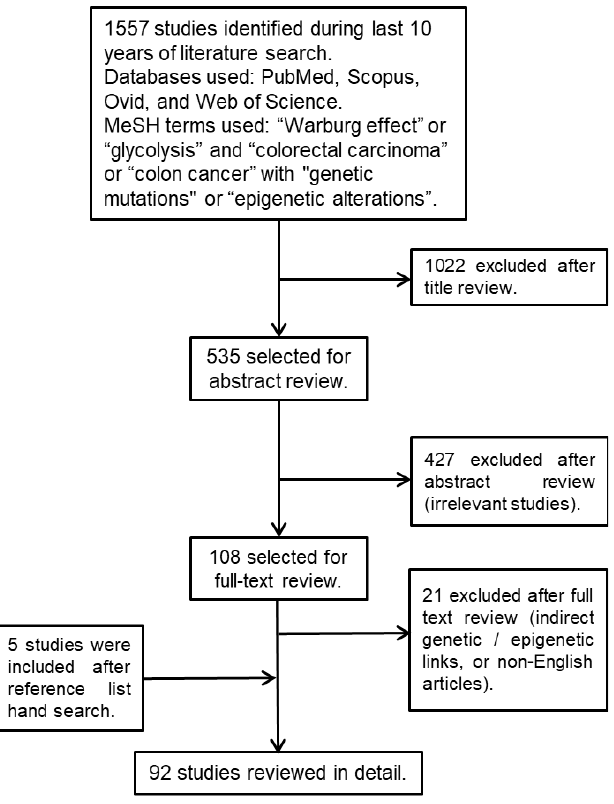
Figure 1. Flowchart outlining the strategy employed to identify the relevant studies.